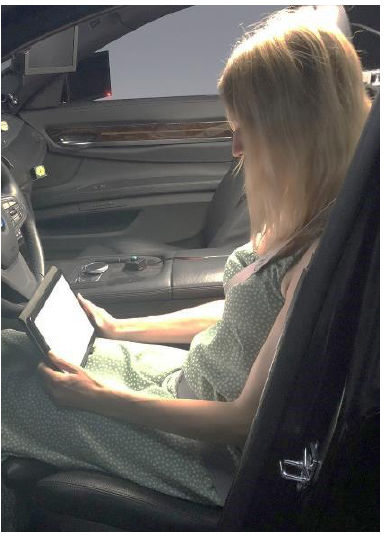
Figure 4. Instructed sitting and head position in which the reading task was